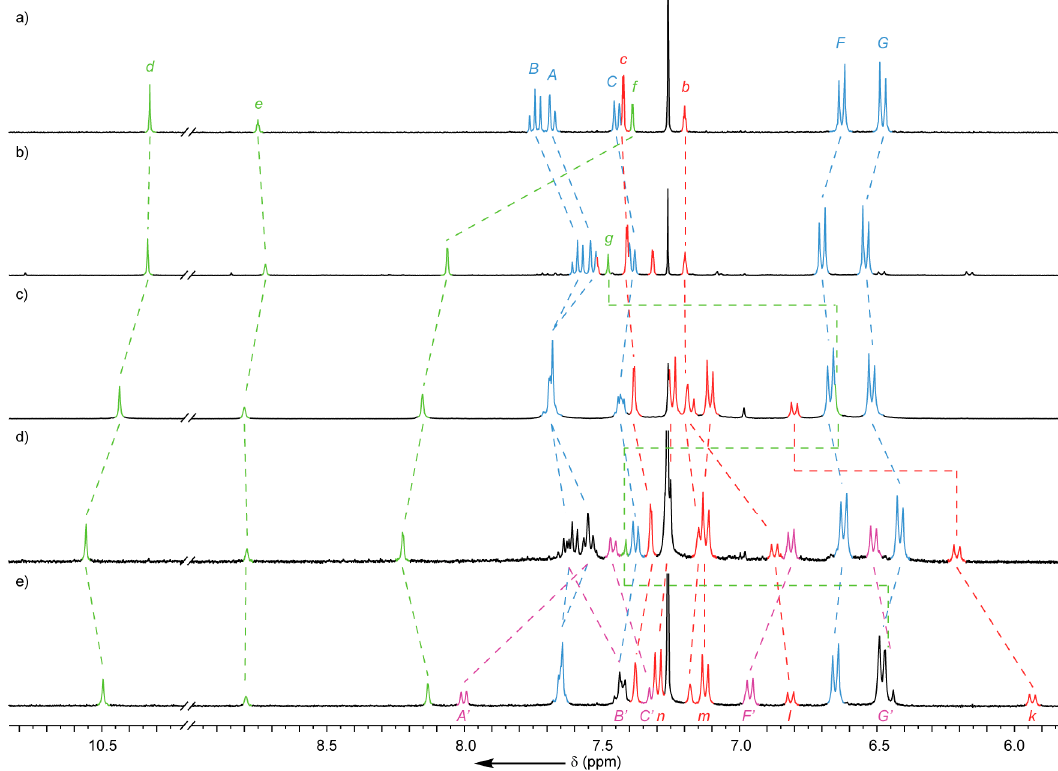
Figure 3. Partial 1 H-NMR spectra (CDCl 3 , 400 MHz, 298 K) of [3]rotaxanes ( a ) 8 ; ( b ) 11a ; ( c ) 11b ; and [4]rotaxaes ( d ) 12b and ( e ) 12c . For macrocycle and thread labeling see Scheme 3.